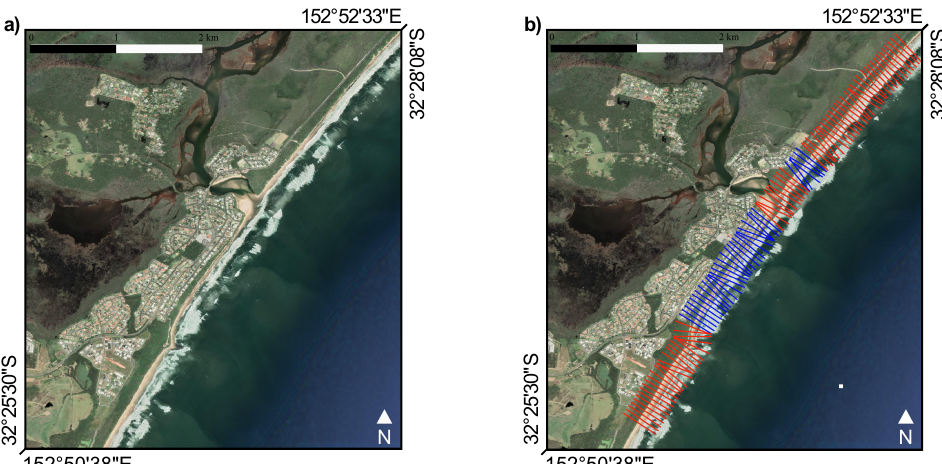
Figure A1. For selected areas of interest ( a ), the algorithm creates a set of transects perpendicular to the detected shoreline ( b ) and evaluates whether they intersect urban agglomerates (in blue) or not (in red)